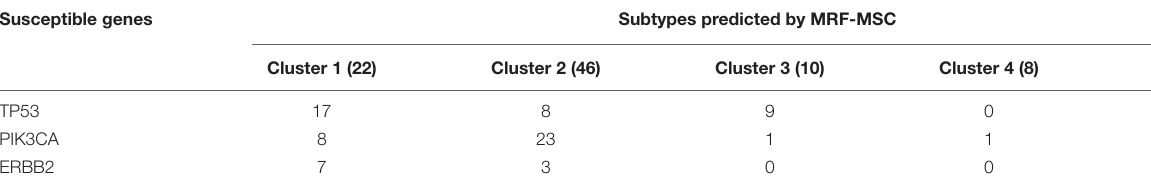
TABLE 5 | The distribution of clustering results of MRF-MSC on three susceptible genes: TP53, PIK3CA, and ERBB2. Susceptible genes